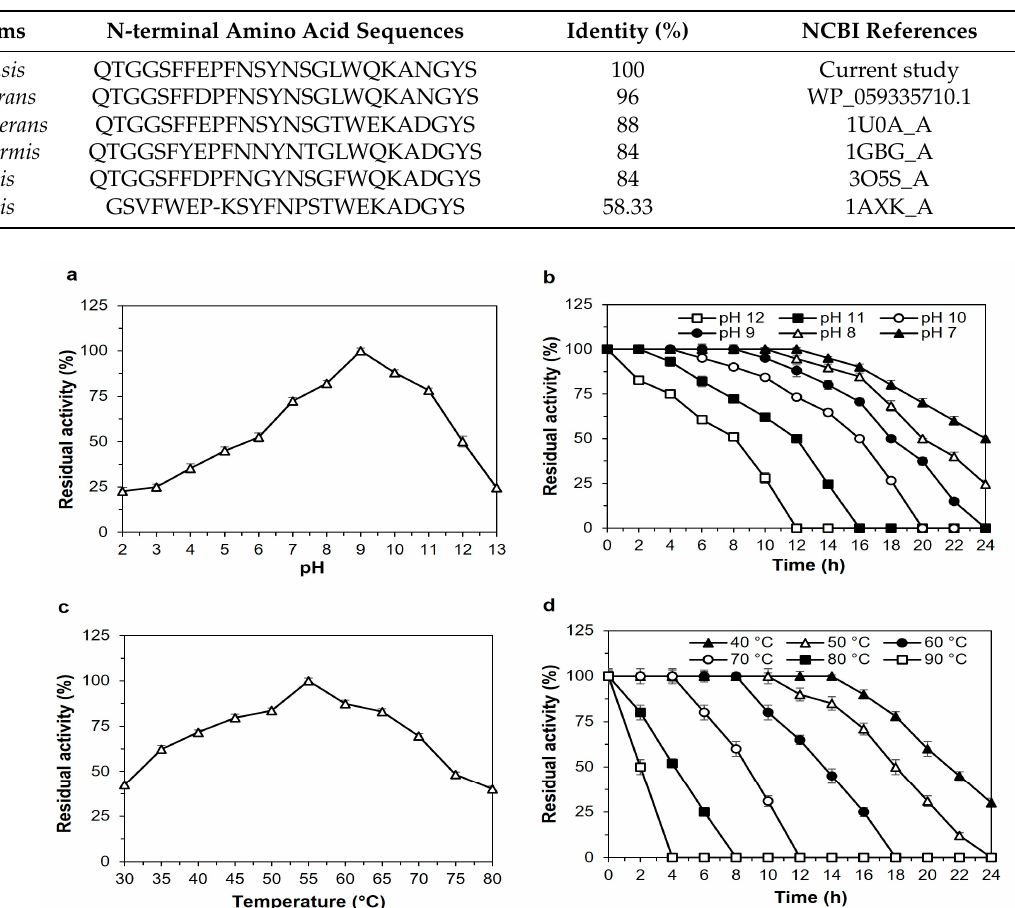
Table 2. Alignment of the N-terminal acid sequence of purified protease SH21 with theoretical proteins from various Bacillus sp.